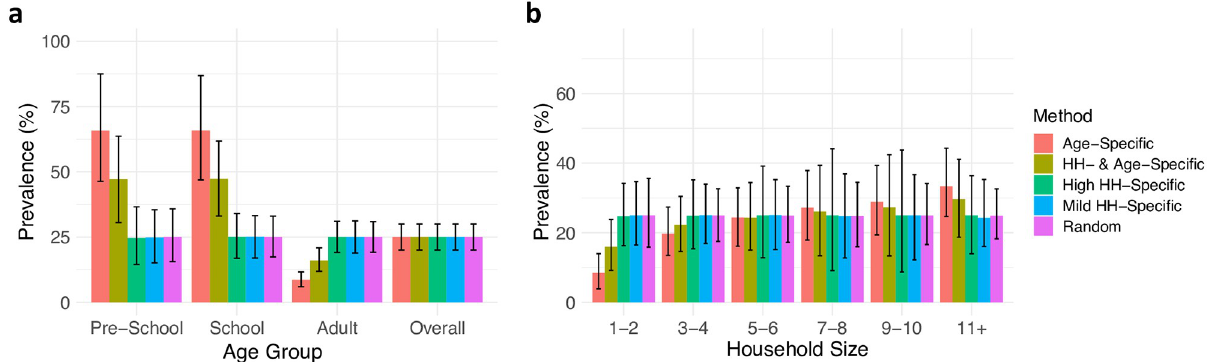
Fig 4. (A) Distribution of scabies prevalence in age groups for different scabies assignment methods, (B) Distribution of scabies prevalence across household size groups for different methods of scabies status assignment. The results (median and 2.5% to 97.5% quantiles) are plotted for an exemplar input prevalence percentage between 20–30% across all population sizes. In the legend, “HH” refers to